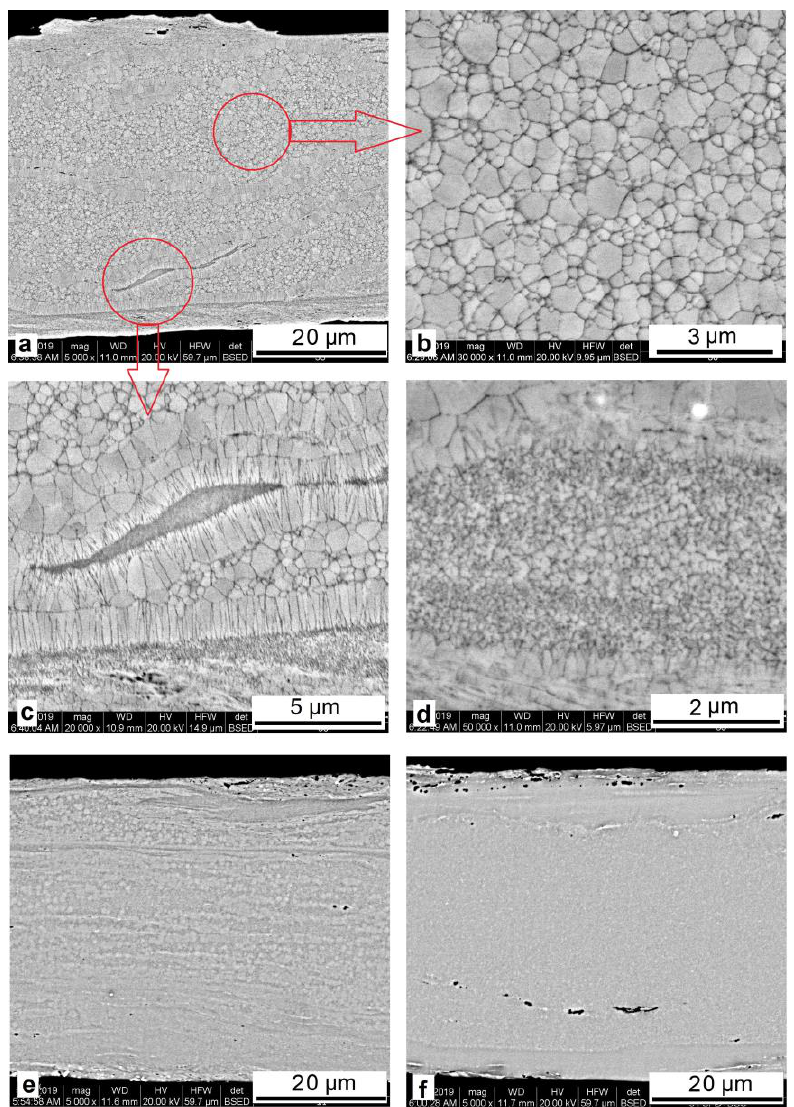
Figure 7. Cross section of the melt-spun TiNiCu ribbons containing 30 at.% Cu ( a – d ), 34 at.% Cu ( e ), and 38 at.% Cu ( f ) after HPT ( n = 5) and crystallization in the calorimeter.